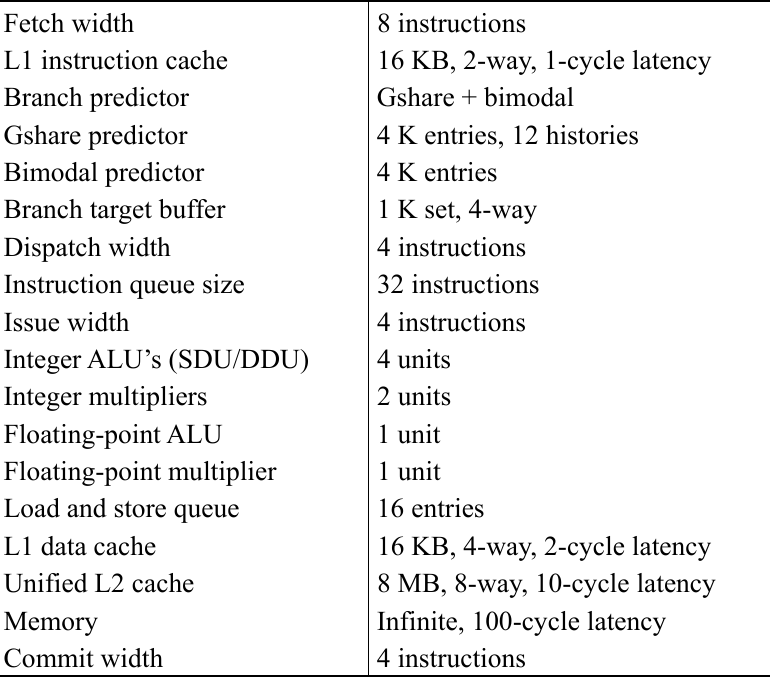
Table 1. Processor core